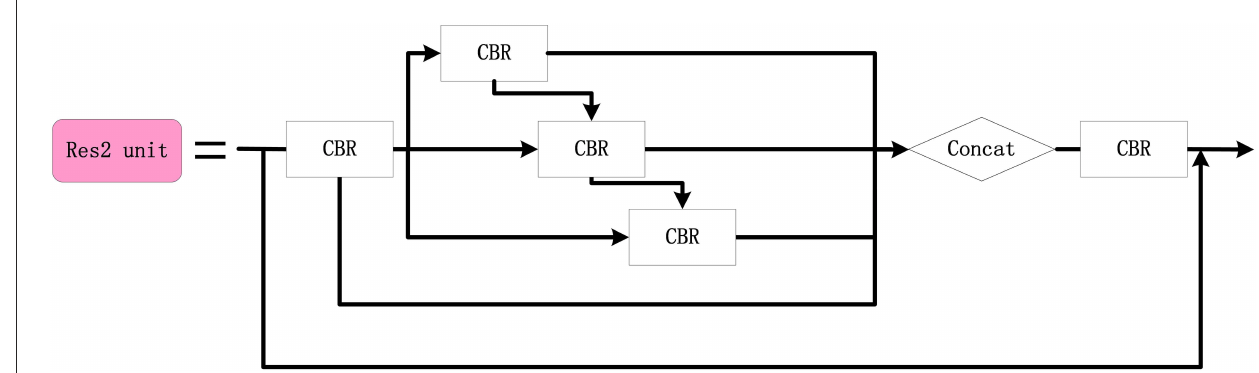
FIGURE9 The configuration of the Res2 unit module.